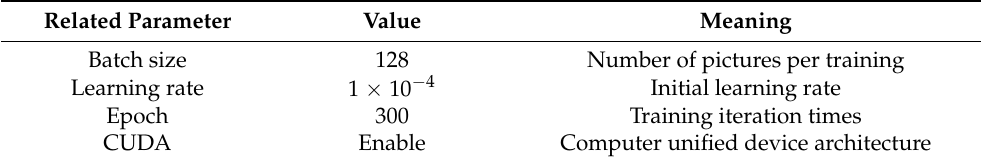
Table 4. Training parameters.